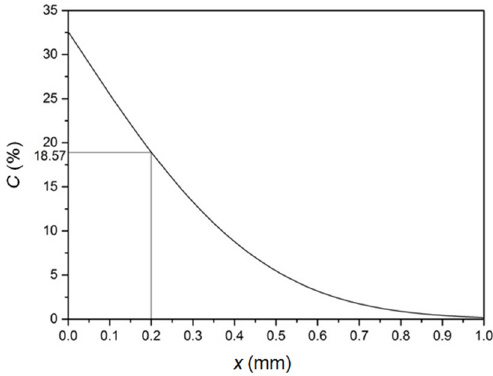
Figure 10. Calculated concentration–distance ( C – x ) profile at 600 ◦ C in the case of a 0.2 mm thickness